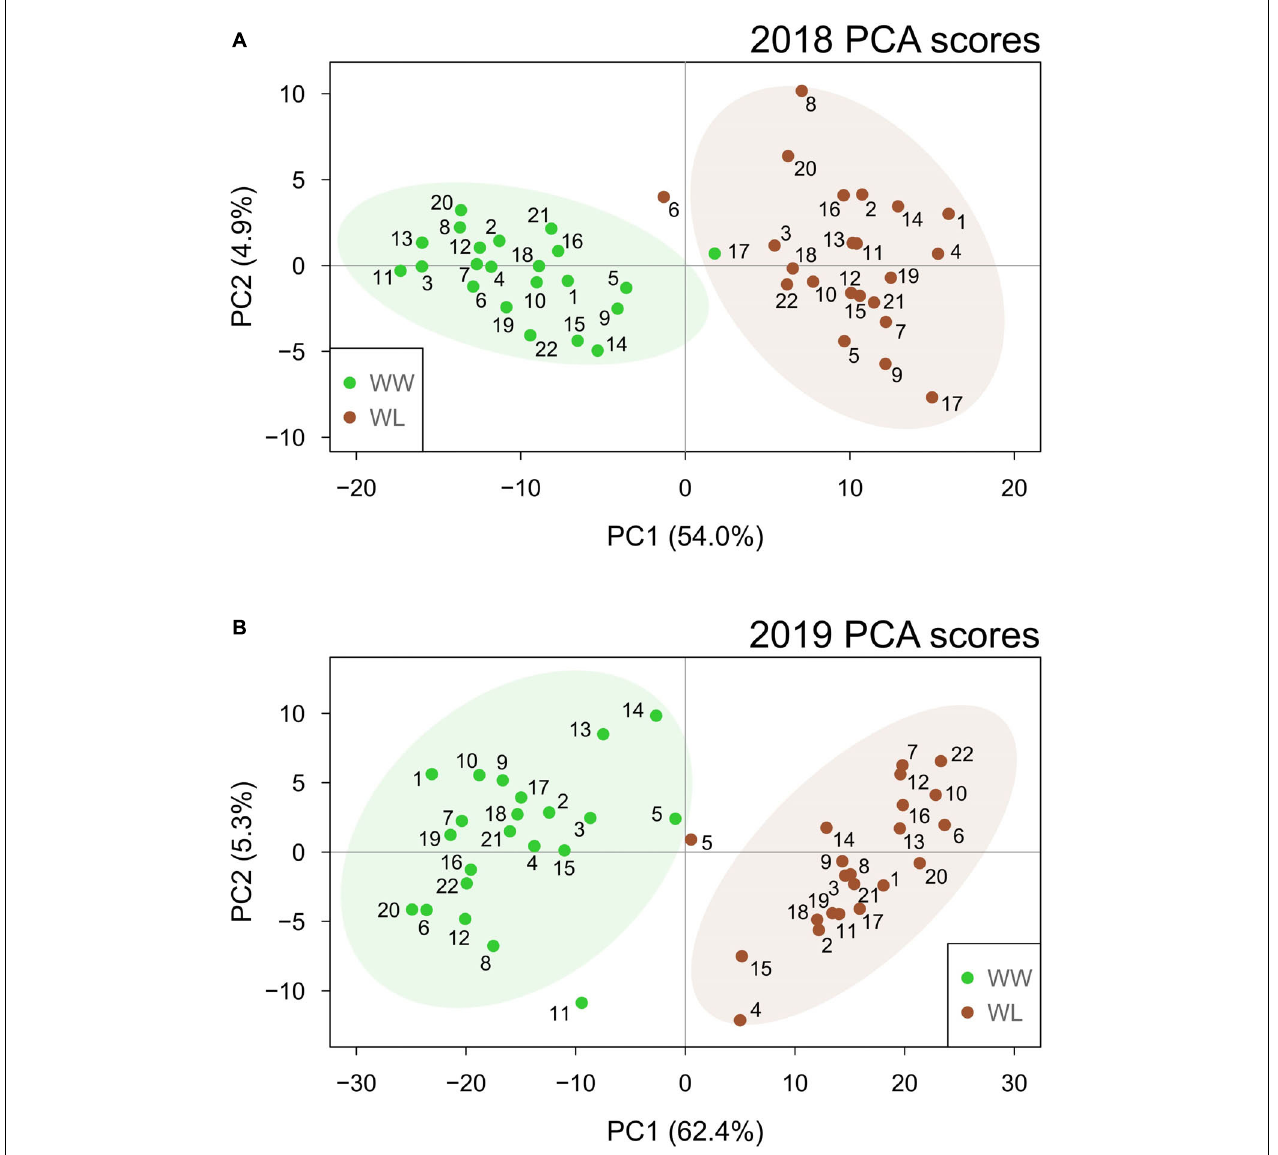
FIGURE 2 | Principal component analysis score plots based on the well-watered (WW, green) and water-limited (WL, brown) values of leaf metabolites for the 22 cotton accessions in 2018 (A) and 2019 (B) . The percentage of sample variation explained by the first two principal components (PC1 and PC2) is reported in brackets. The number of each sample relates to the “Current study number” column in Supplementary Table 1 . Ellipses represent the 95% confidence level for the samples of each